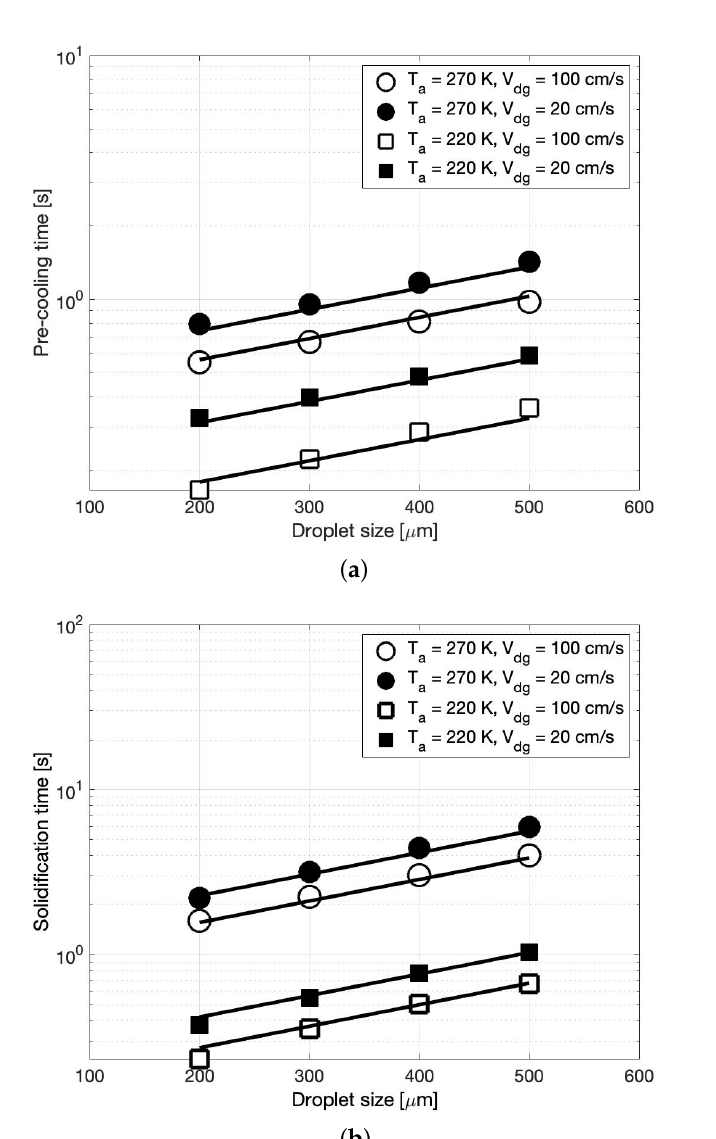
Figure 4. CFD simulation estimates of ( a ) the pre-cooling time and ( b ) the solidification time, as a function of the droplet size for several combinations of ambient temperature and relative drop- gas velocity (symbols). Trendlines (solid line) in ( a ) is as per Equation (14) and in ( b ) is as per Equation